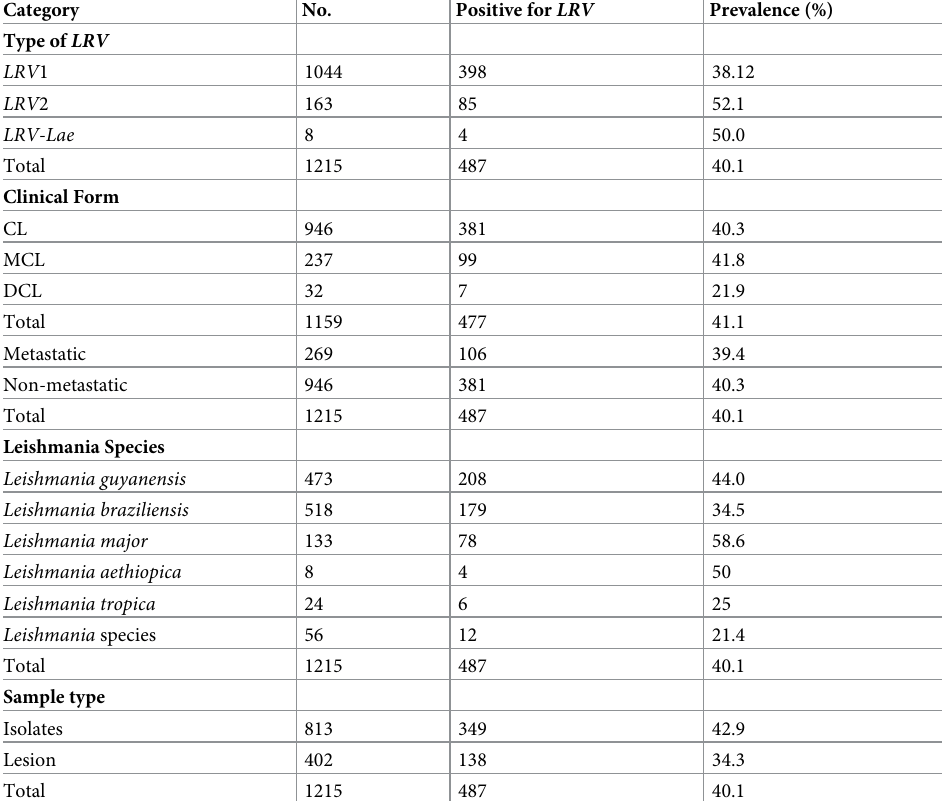
Table 2. Summarized data extracted from the included studies for sub-group analysis in the meta-analysis. Category No. Positive for LRV Prevalence